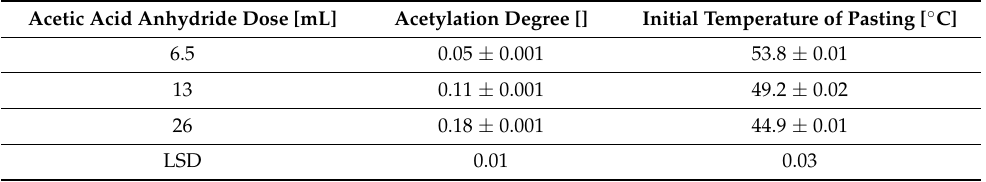
Table 1. Degree of substitution and initial temperature of pasting of large granules of starch acetylated with various doses of an acetic acid anhydride.